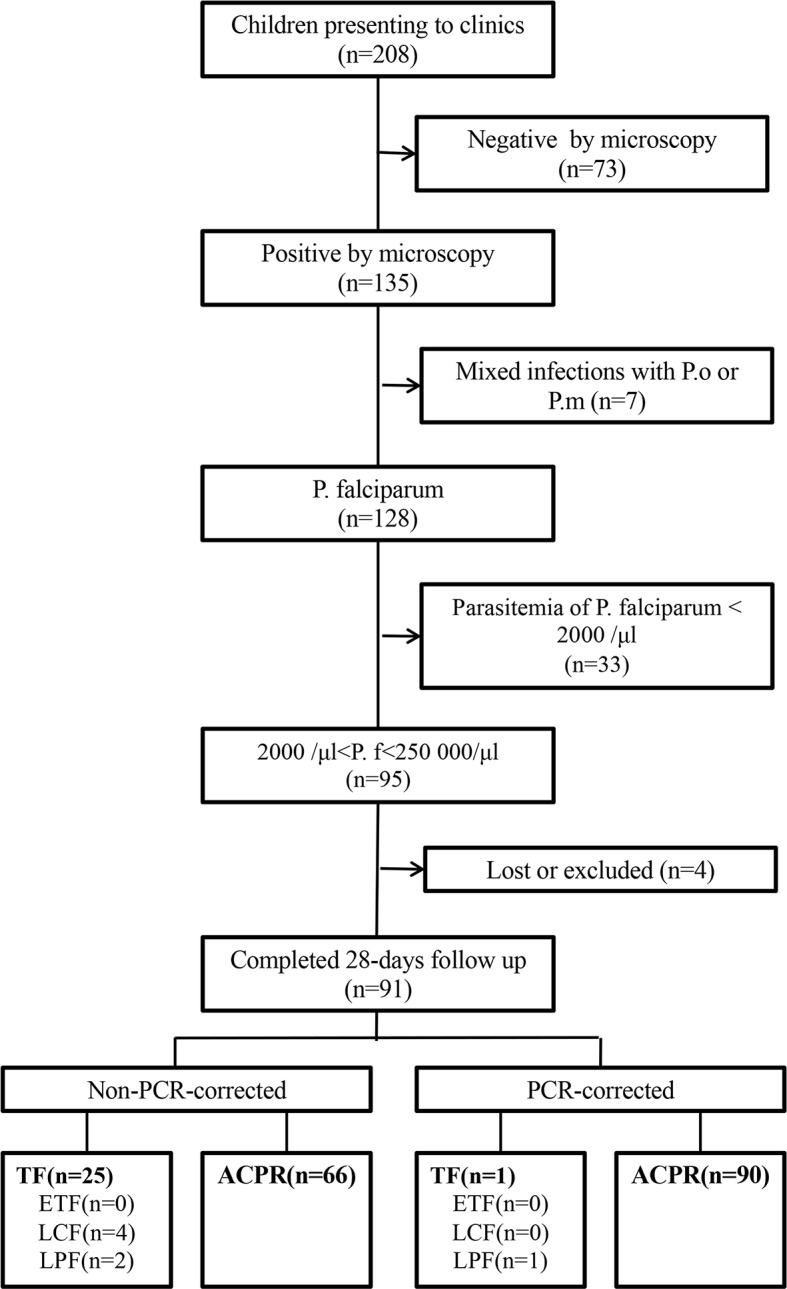
Patient flow chart in the clinical trial. ACPR, adequate clinical and parasitological response; ETF, early treatment failure; LCF, late clinical failure; LPF, late parasitological failure; TF, treatment failure; P.f, Plasmodium falciparum; P.m, Plasmodium malariae; P.o, Plasmodium ovale.